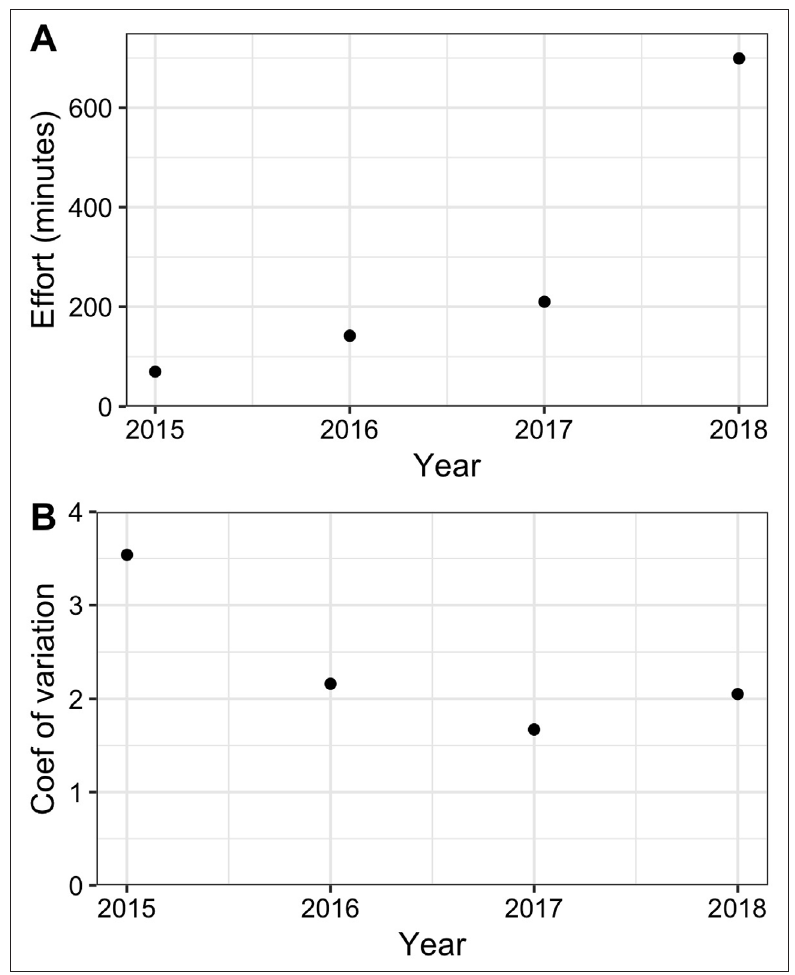
Figure 2: A) Sampling effort and B) coefficient of variation in data collected during citizen science SCUBA diving surveys for young-of-year, juvenile, and adult rockfish in Puget